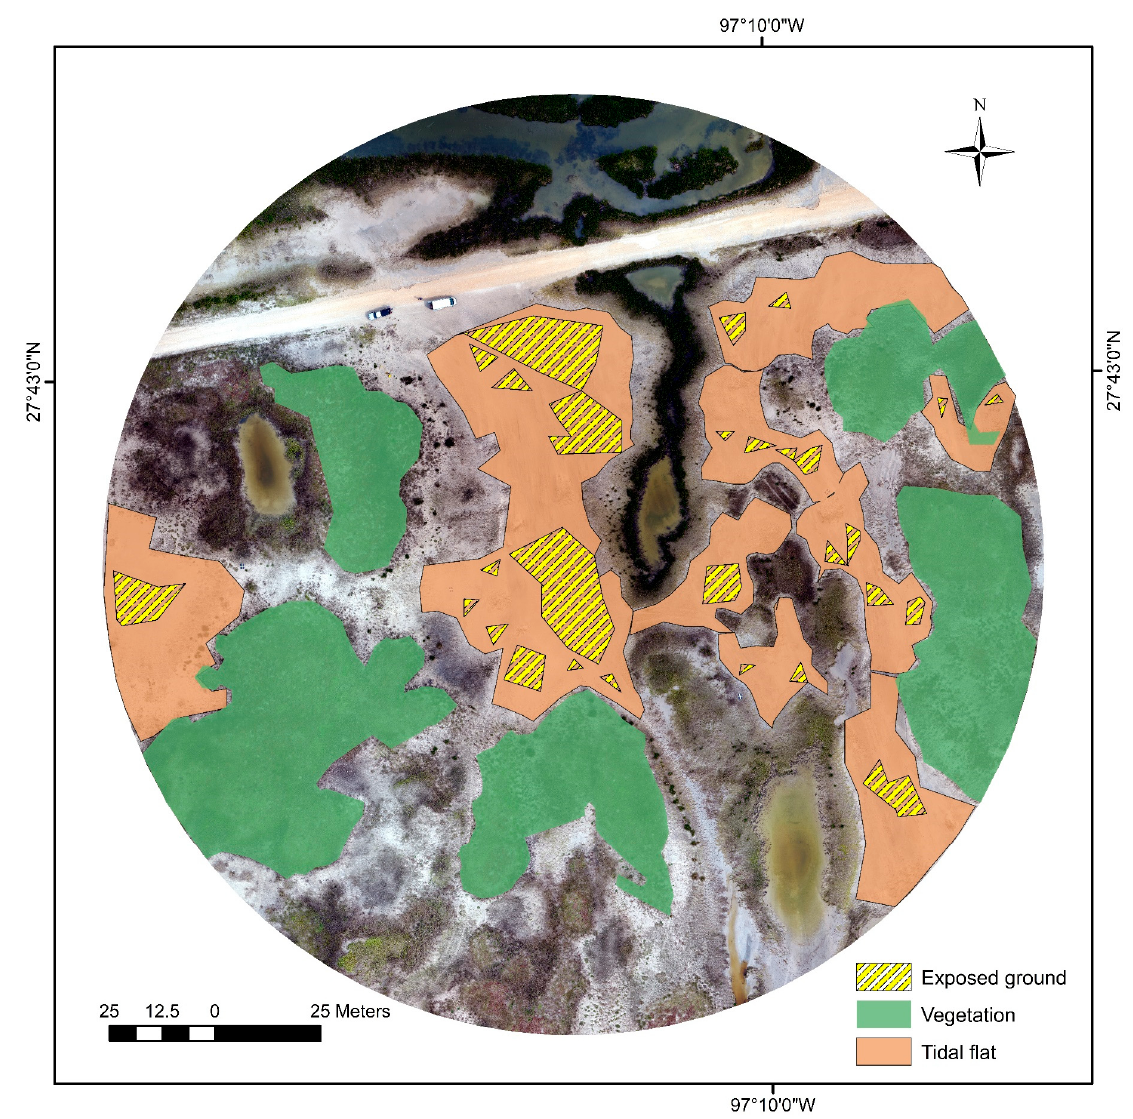
Figure 8. Combined polygon for tidal flats (blue), vegetated areas (green), and exposed ground (yellow) used for accuracy assessments.